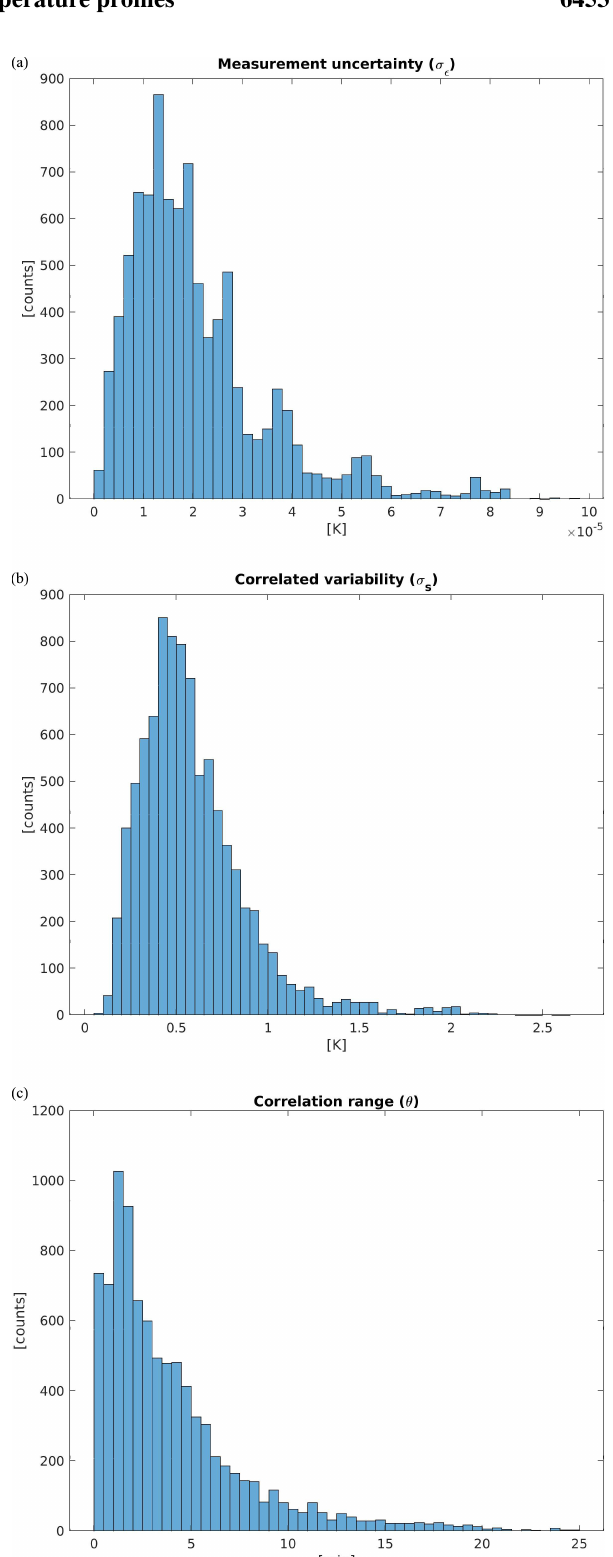
Figure 8. Linear interpolation uncertainty of GRUAN sites. The cross-validation uncertainty ( x axis) is based on the RMSE and missing fraction f = 0 . 13. (a) Average gap size is µ G = 4s; (b) av- erage gap size is µ G = 10s; (c) average gap size is µ G = 30s.